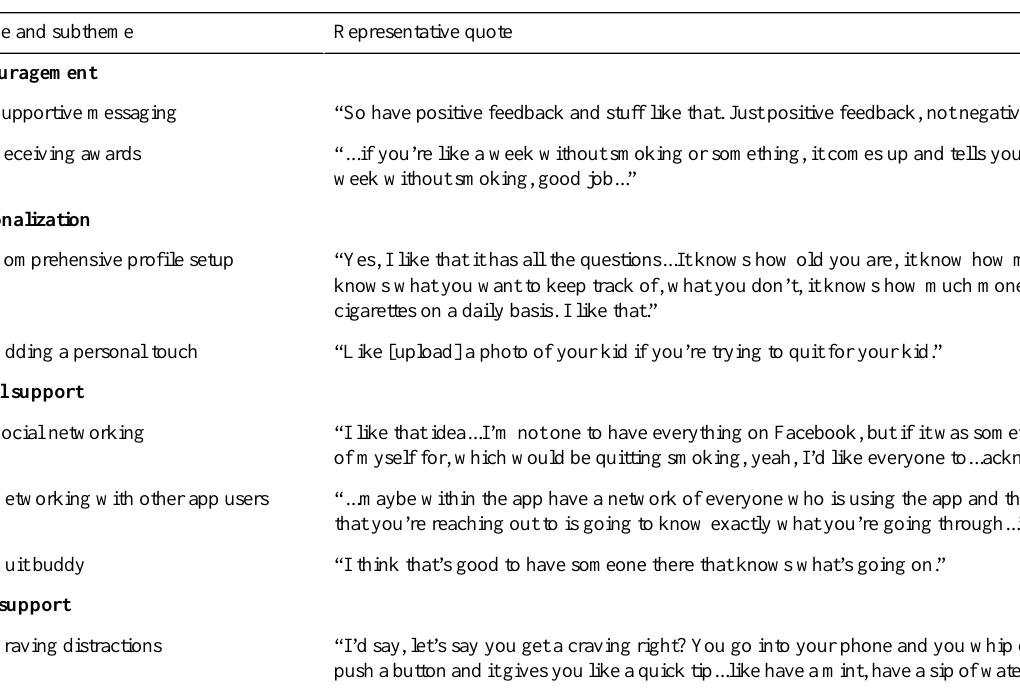
Representative quoteTheme and subtheme